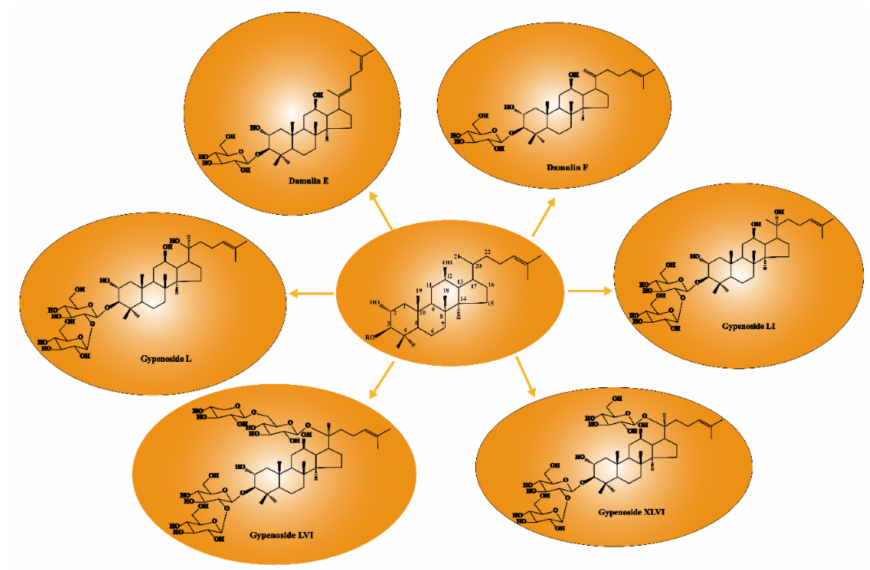
Figure 5. Relationship between anti-cancer activity and structure of GPS.